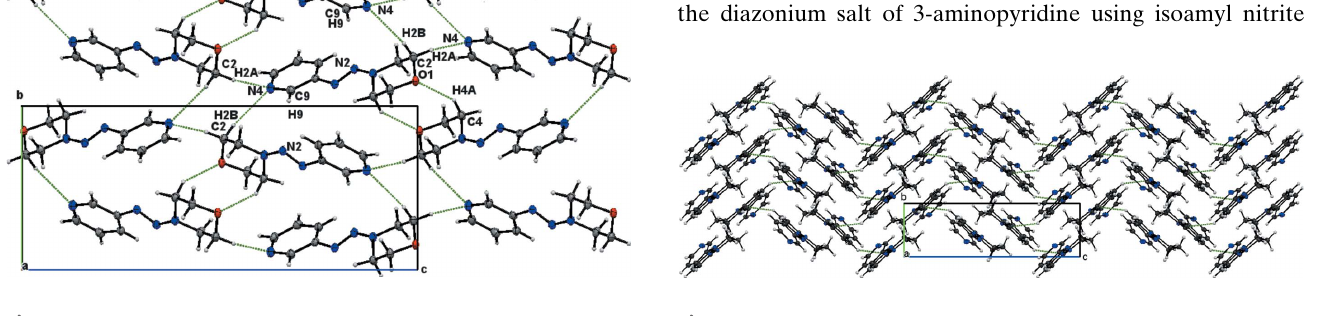
Figure 4 Layers of compound II parallel to the bc plane.